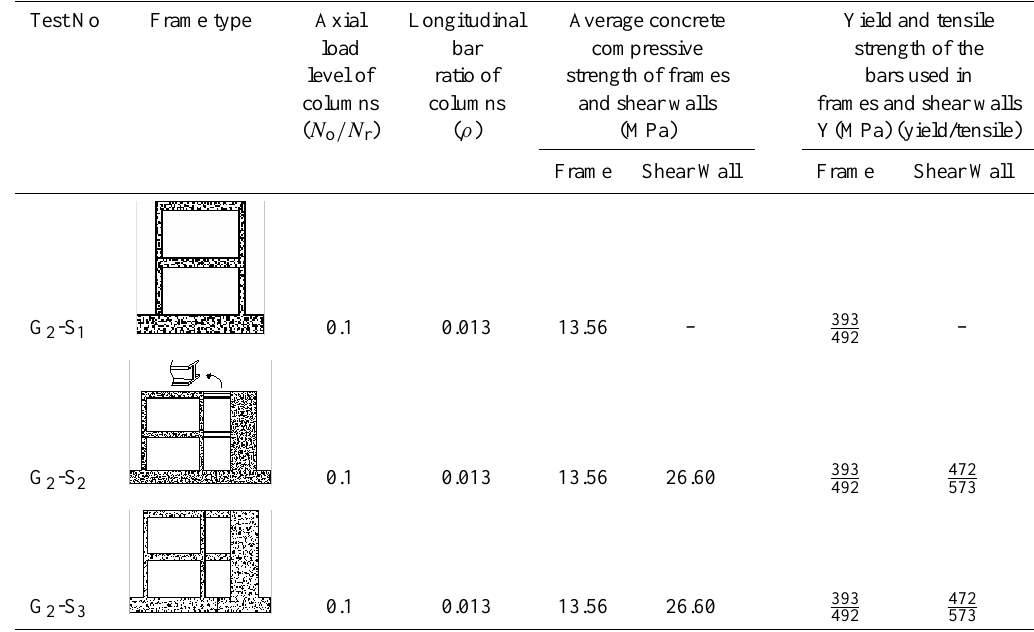
Table 2. Characteristics of the specimens in the 2nd test program.